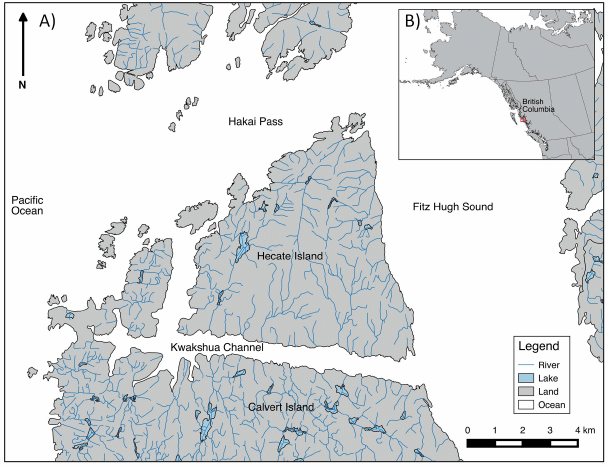
Fig. 1 . Kwakshua Channel, located between Calvert and Hecate islands, on the central coast of British Columbia, Canada encompasses a diversity of archaeological features (Table 1) and evidence of ancient marine use and management, including eight clam gardens. Radiocarbon dates suggest that people inhabited this region during the early Holocene, from at least 8000-10,000 years B.P. (McLaren and Christensen